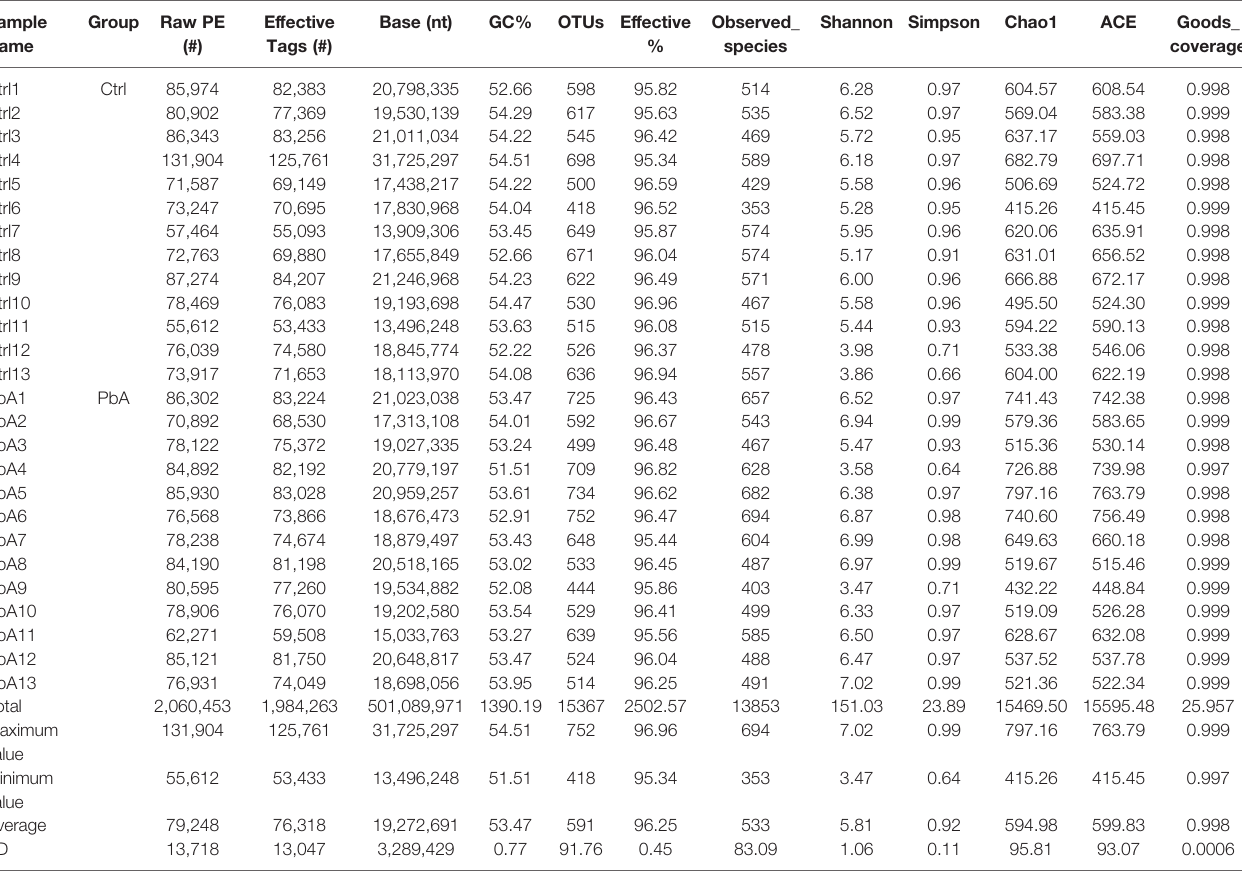
TABLE 1 | Operational taxonomic unit (OTU)-base diversity indices in infected and uninfected mouse gut